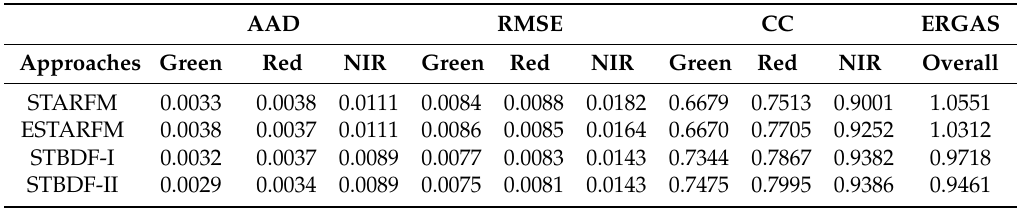
Table 2. Quantitative metrics of the fusion results of the simulated images.